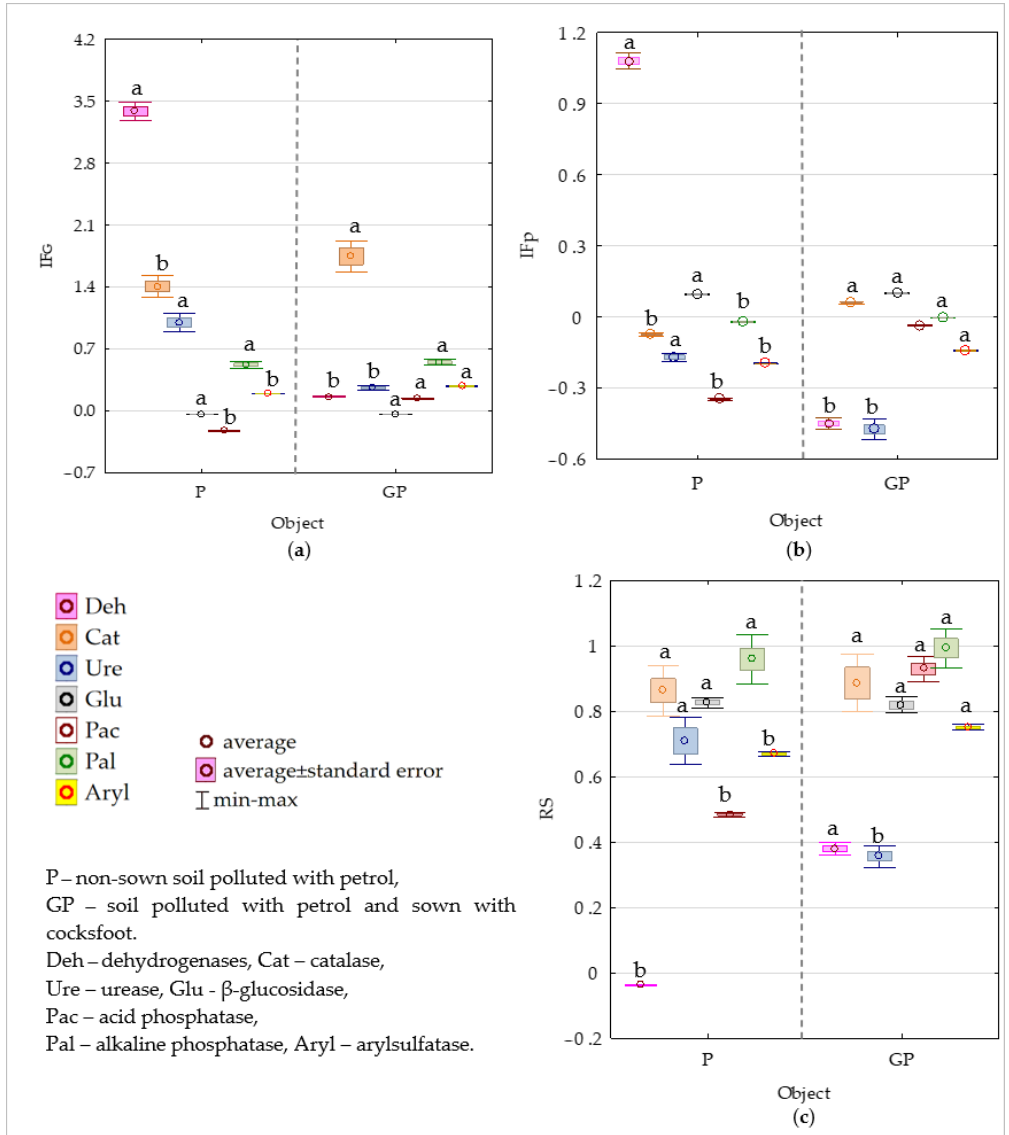
Figure 8. Indices of: ( a ) cocksfoot effect (IF G ) on the activity of soil enzymes, ( b ) petrol effect (IF P ) on the activity of soil enzymes, and ( c ) resistance (RS) of soil enzymes to the effects of petrol (P). Homogeneous groups denoted with letters (a,b) were calculated separately for each enzyme.